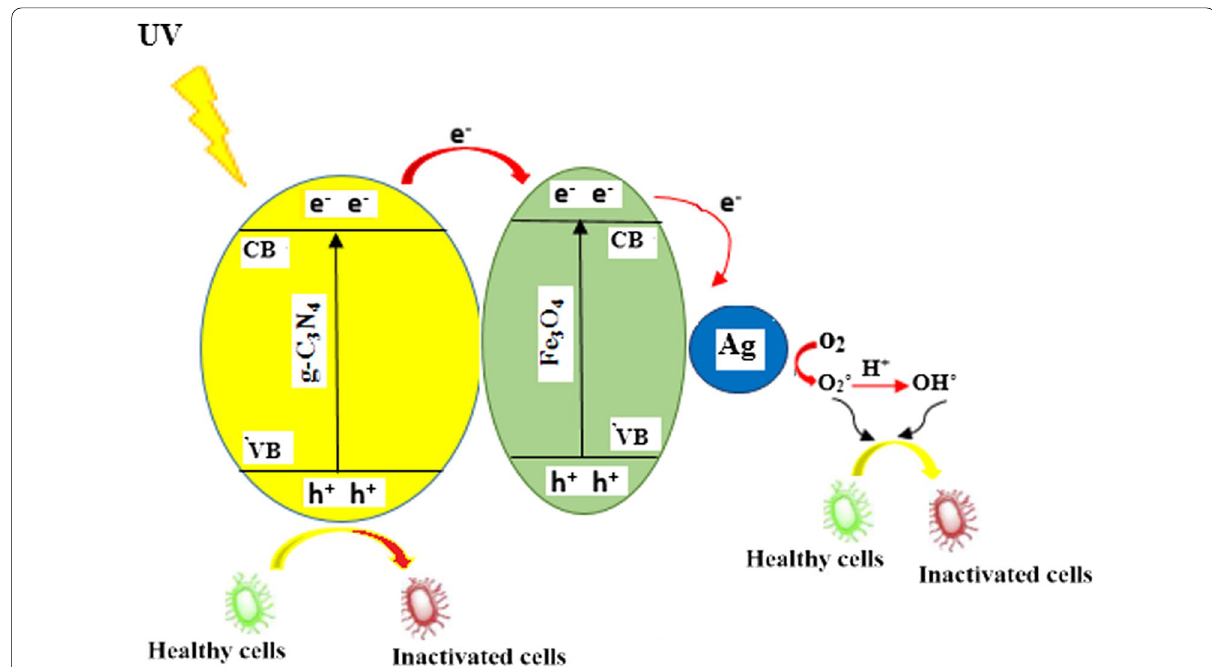
Fig. 7 A schematic diagram representing the photocatalytic mechanism proposed for the inactivation of E. coli and B.